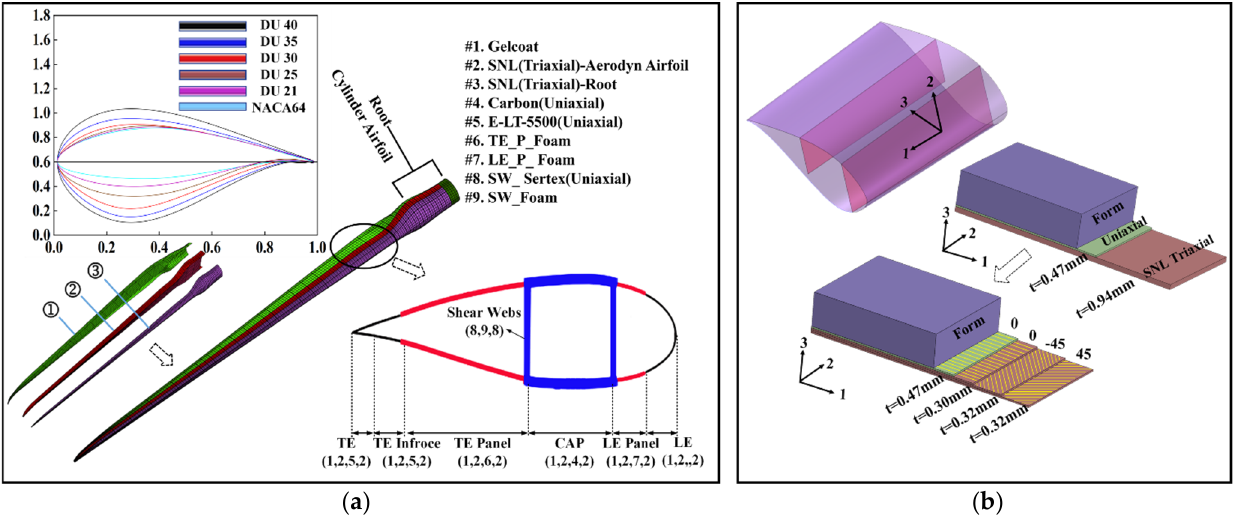
Figure 1. Blade geometry model and laminate fiber orientation definition. ( a ) Blade geometry model. ( b ) Laminate fiber orientation definition.